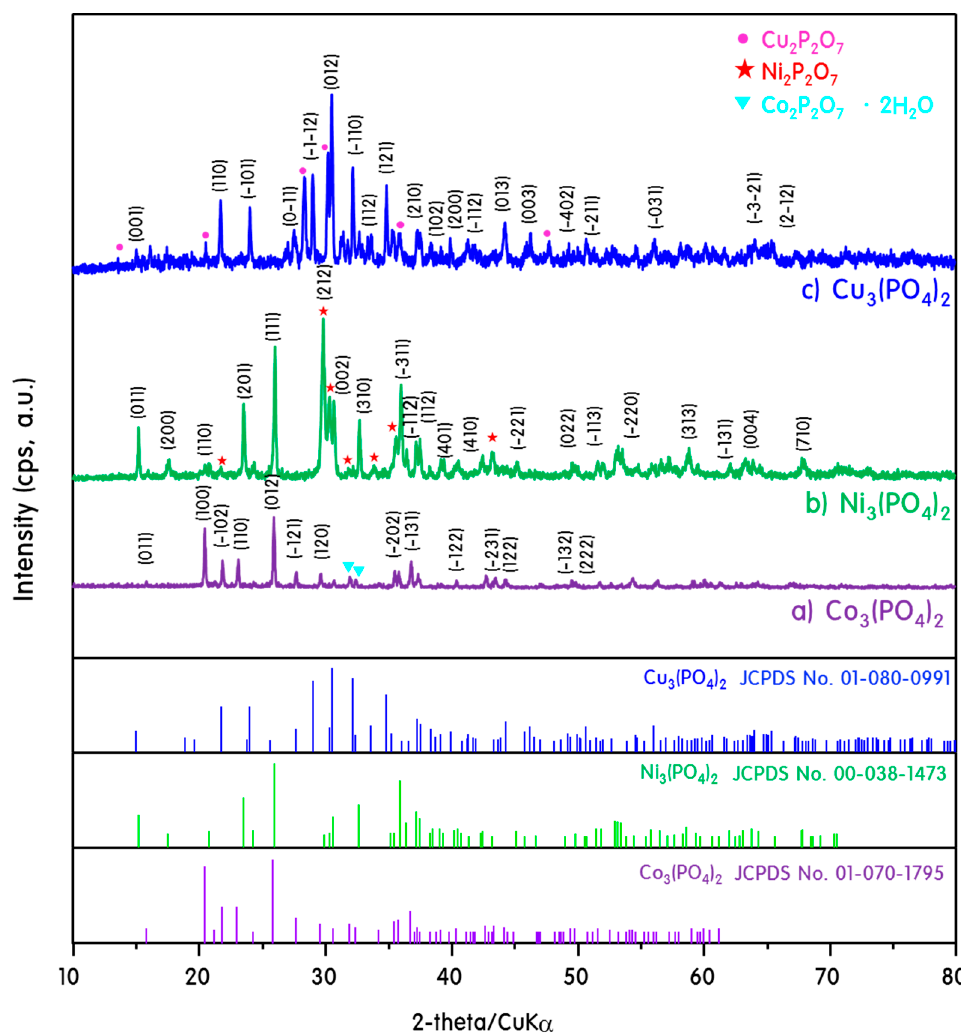
Figure 1. X-ray di ff raction (XRD) patterns of the M 3 (PO 4 ) 2 -M 2 P 2 O 7 mpc (M = Co, Ni, and Figure 1. X-ray diffraction ( XRD) patterns of the M 3 (PO 4 ) 2 -M 2 P 2 O 7 mpc (M = Co, Ni, and Cu).